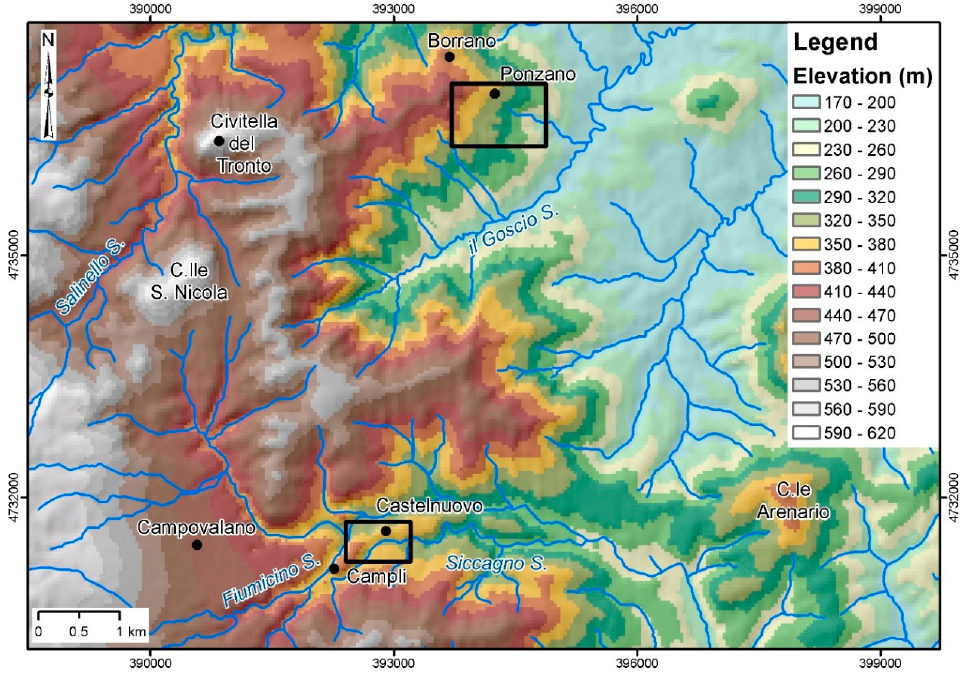
Figure 5. Elevation and hydrography map of the study area. The black boxes indicate the Ponzano landslide and Campli landslide areas.